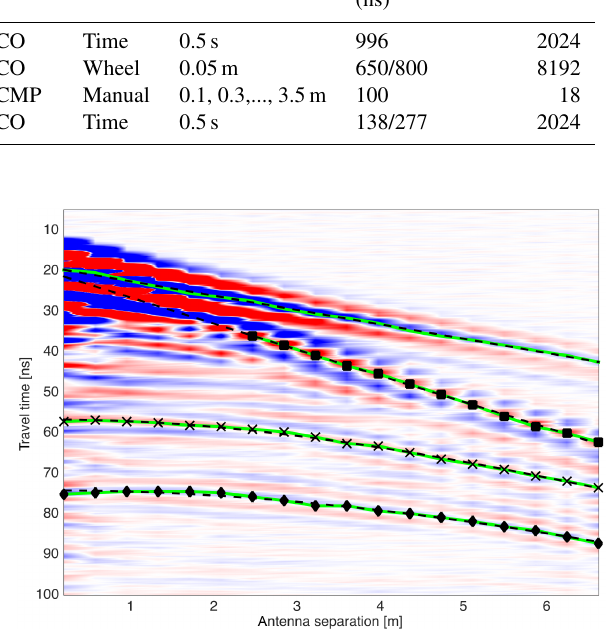
Figure 3. Evaluation of common midpoint profile. Picking was exe- cuted by a semi-automated algorithm tracing a centre feature of the respective pulse throughout the radargram. Green lines show picks for direct air and ground wave (no symbol and dots, respectively) and internal reflections (crosses and diamonds). The lower two re- flectors (crosses, diamonds) were used for permittivity and wave speed estimation. For this purpose a hyperbola fit (dashed line) was calculated based on the picked values using the time zero offset as derived from the direct air